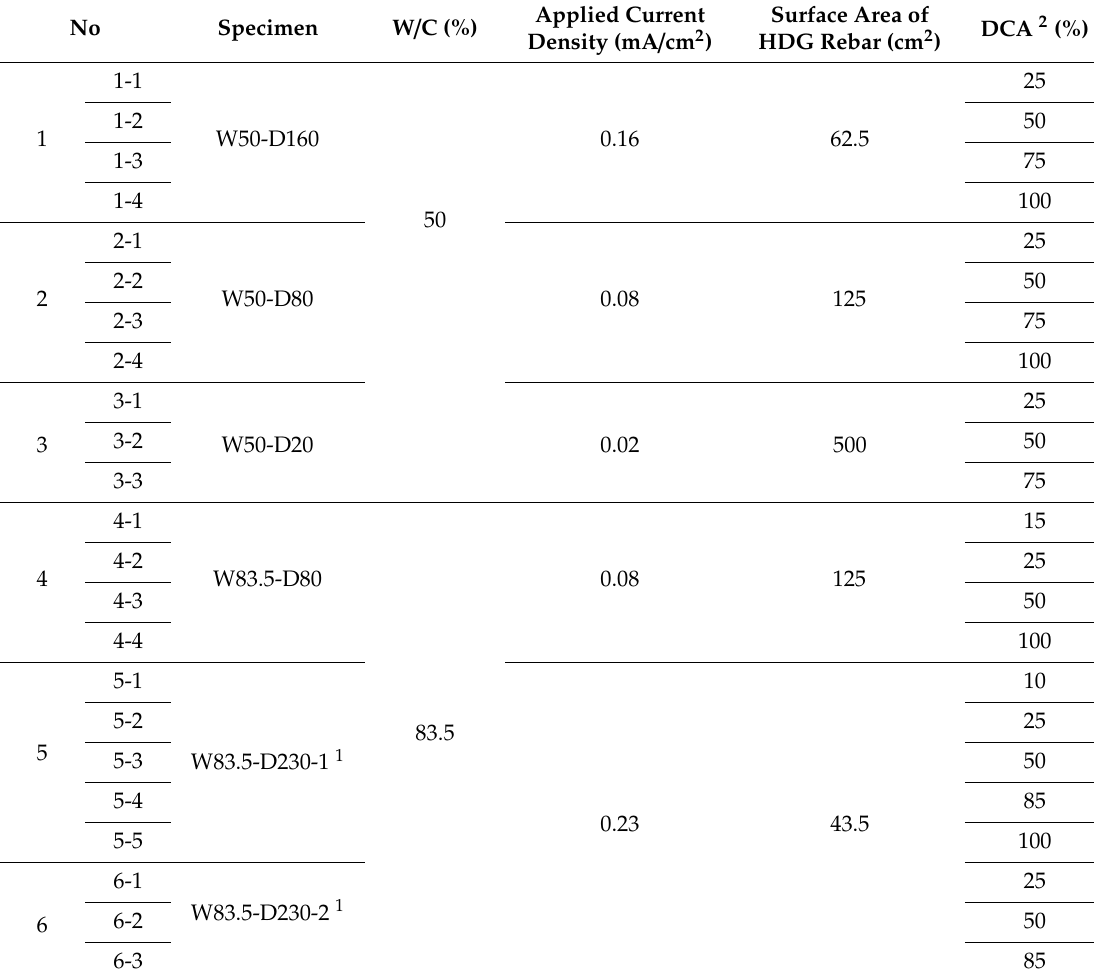
Table 1. Specimen list and experimental